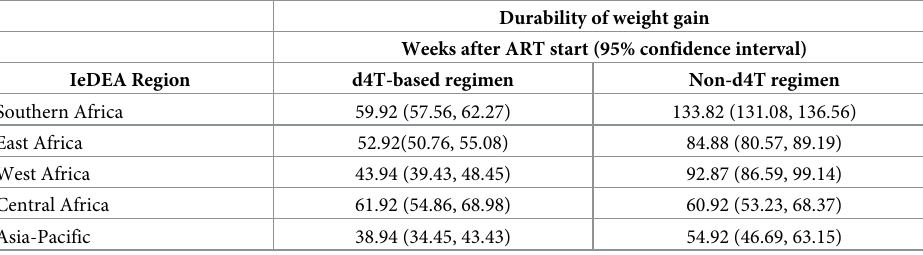
Table 3. Estimated weeks at which HIV-patients experienced non-increasing